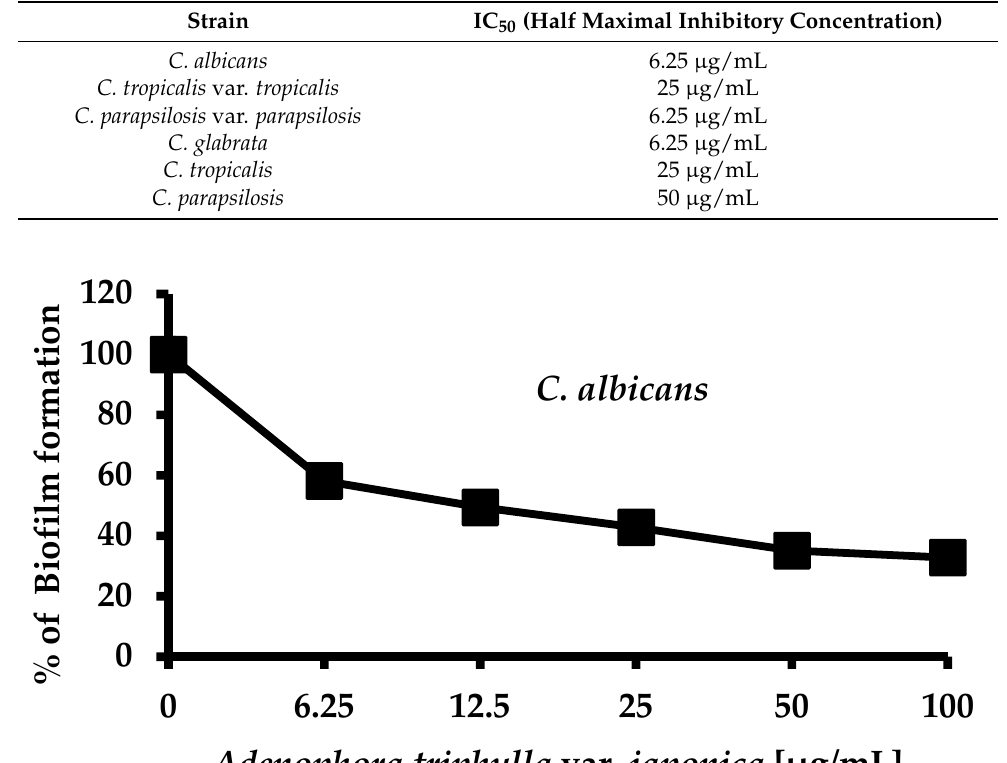
Figure 2. A. triphylla var. japonica extracts inhibited biofilm formation of C. albicans pp. Biofilm formation of C. albicans were induced in RPMI1640 with indicated concentrations of A. triphylla var. japonica extract for 24 h at 37 °C. Experiments were performed in